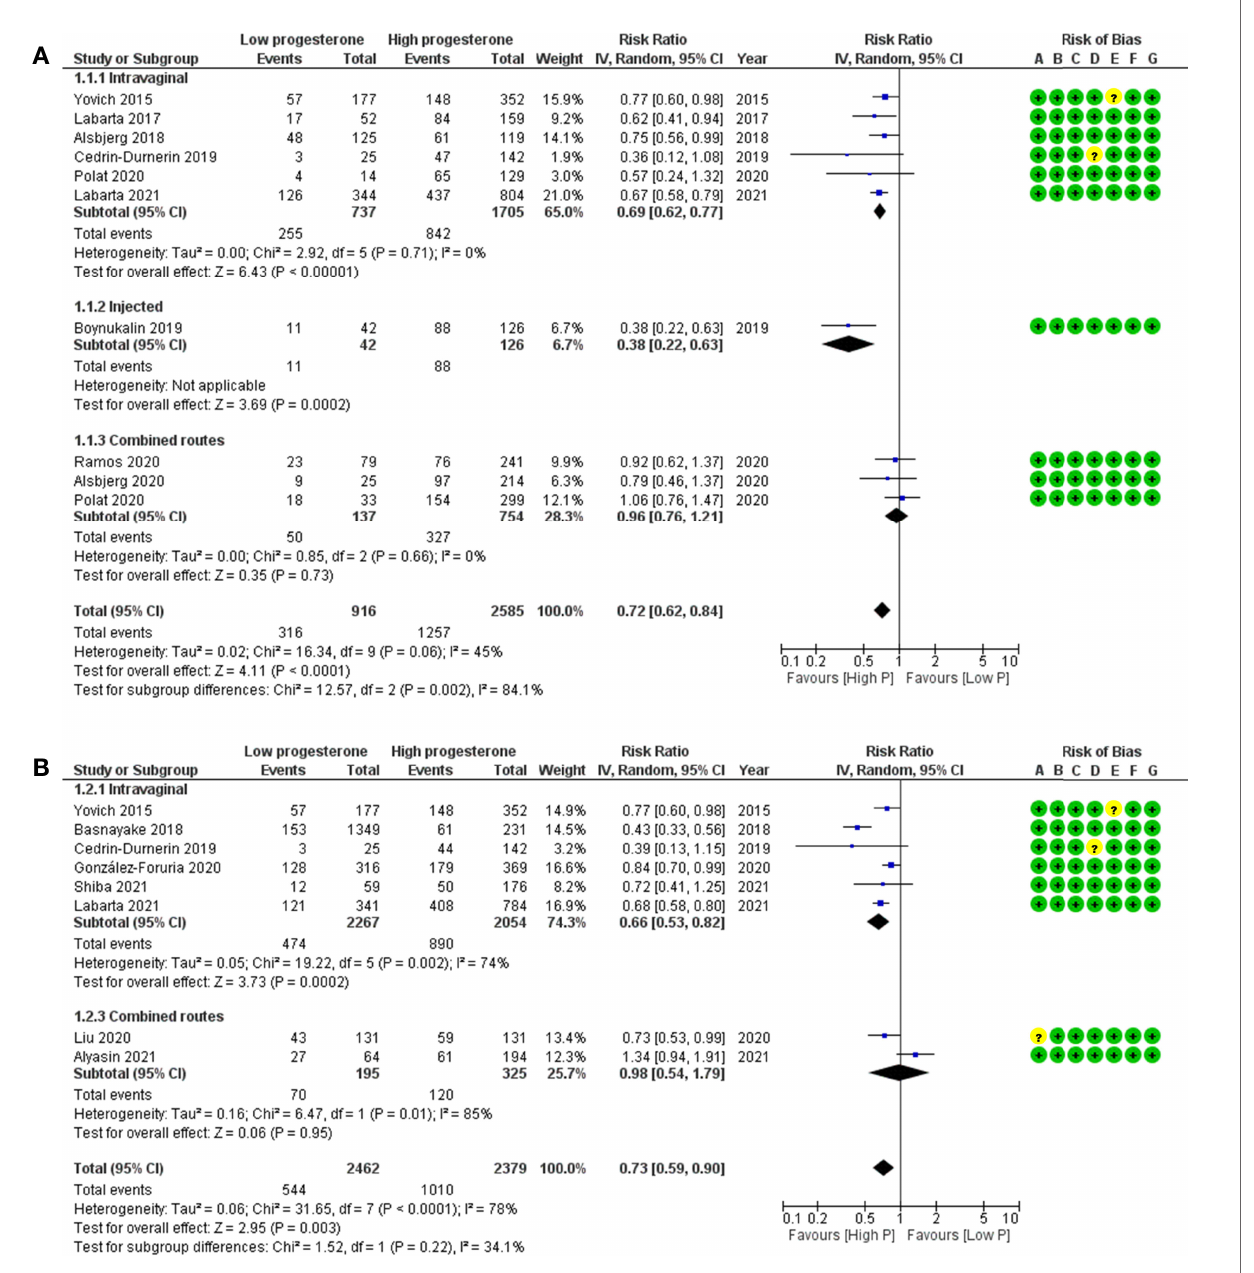
FIGURE 4 | Forest plots of studies “ several corpora lutea ” according to time of progesterone determination for (A) ongoing pregnancy and (B) live birth. Risk of bias legend: 1, confounding; B , selection of patients; C , classi fi cation of intervention; D , deviations from intervention; E , missing data; F , measurement of outcome; G , selection of reported